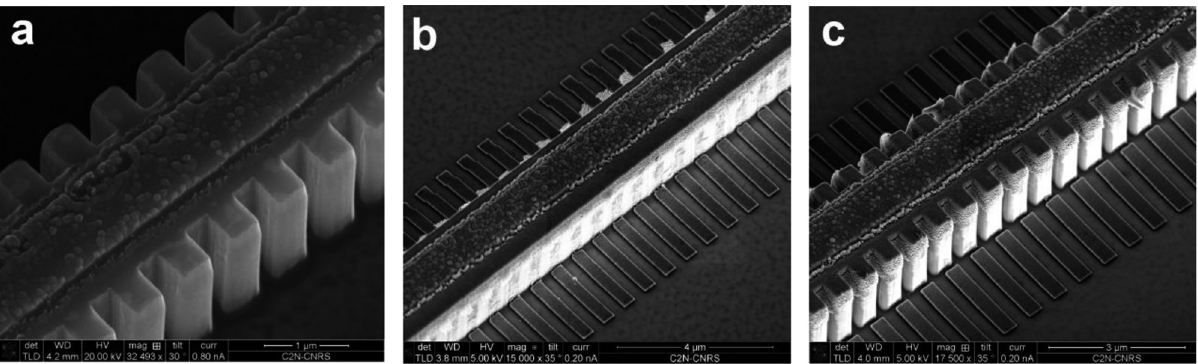
Figure 2: SEM pictures of fabricated Distributed Feedback laser diodes (DFB) lasers. a)Index-coupled(IC)DFBwiththird-orderdielectricgrating;b)gain-coupled(GC)DFBwiththird-ordermetallicgrating;c)third-ordercomplex- coupled (CC) DFB. Bragg grating periods amount to about 750